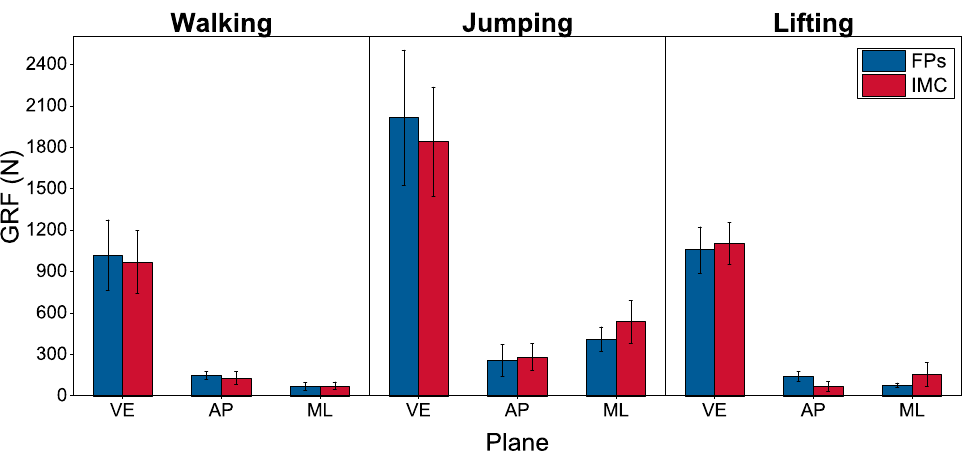
Figure 6. Average peak FP measured (blue bars) and IMC predicted (red bars) components of the total GRF during walking, jumping, and lifting; VE = vertical component, AP = anterior-posterior component, ME = mediolateral component.